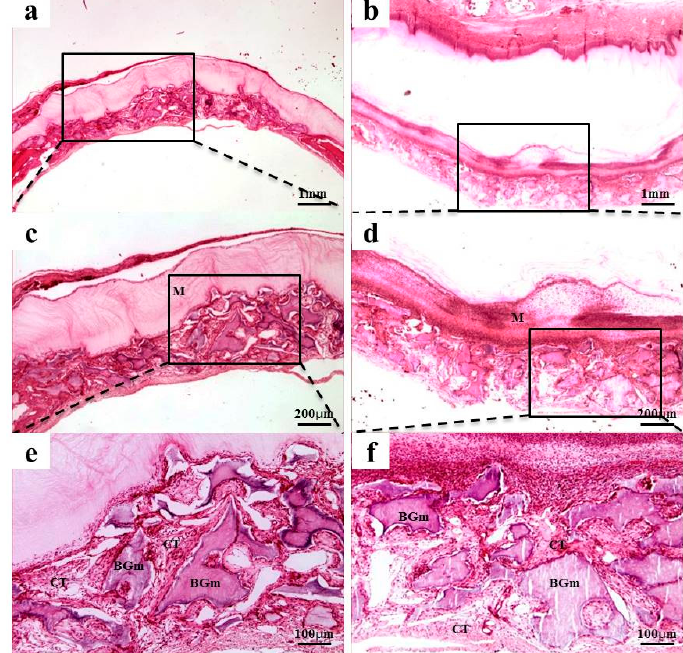
Figure 4. BC membranes: 0.15 mm and 0.20 mm. Histological sections of defect sites at 2 weeks after surgery: ( a , c , e ) 0.15 mm BC; ( b , d , f ) 0.20 mm BC. Fibrous connective tissues and bone-like materials were observed in the 0.15 mm BC group. NB, Fibrous connective tissue ; M, membrane; CT , connective tissue; BGm, bone grafting material. Original magnification: ×20 (a,b), ×40 (c,d), ×100 (e,f).